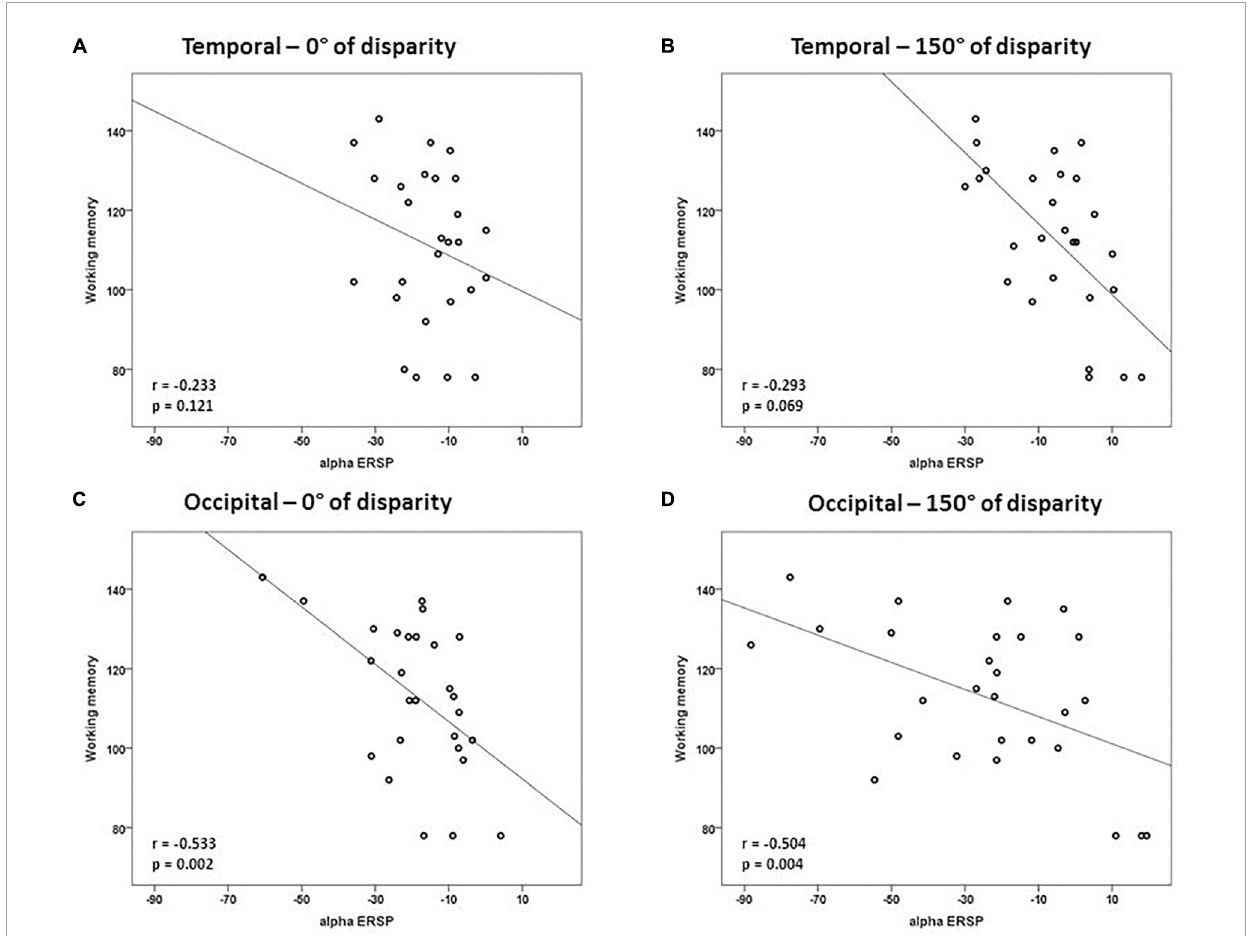
FIGURE4 Correlations between intelligence scores and alpha ERSP in temporal and occipital ROIs. In the occipital ROI, there was a negative correlation between alpha ERSP values and working memory scores during trials with 0 and 150 ◦ of disparity between images. Correlations of easy trials of 0 ◦ of disparity are in panels (A,C) , and of difficult trials of 150 ◦ are in panels (B,D) . Values are in µ V.